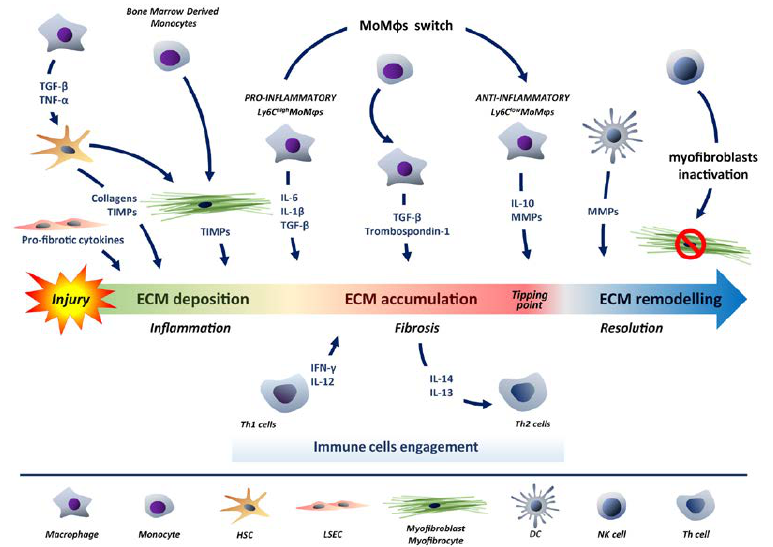
Figure 3. Immune cells engagement in liver regeneration. Hepatic damage induces regeneration, fibrosis and finally implies regression to achieve resolution. Tissue repair takes place by means of ECM deposition. HSCs derived myofibroblasts are primarily responsible for the production of ECM through TIMPs secretion. Secondly, inflammatory background induces bone marrow-recruited monocytes to differentiate into myofibrocytes. LSECs contributes to repair producing pro-fibrotic cytokines. Excessive deposition of ECM induces fibrosis that, if out of control, leads to a tipping point making irreversible ECM accumulation and resulting in liver failure. Monocyte-derived macrophages contribute to ECM accumulation by secreting TGF- β and thrombospondin -1. The two main subsets of hepatic macrophages (MoMϕs) are classified according to Ly6C expression. Ly6C high MoMϕs produce pro -inflammatory IL-6, IL- 1β and TGF - β in the early phases, to switch to Ly6C low